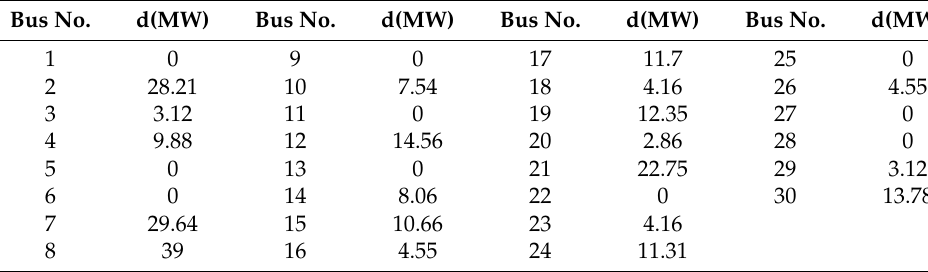
Table A2. Bus data of the modified IEEE 30-bus system.